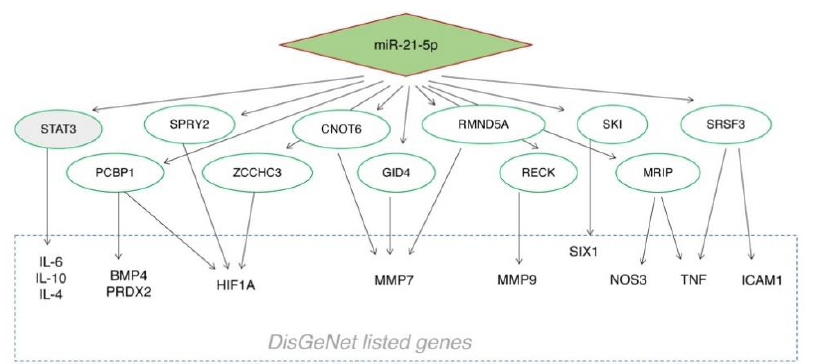
Figure 2. Quantitative analysis of miRNAs expression. qRT-PCR miRNAs expression levels in BOS samples, mir-21 ( a ), mir-146 ( b ), mir34( c ), mir15 ( d ), mir145 ( e ), let7 ( f ), represented as fold changes relative to RNU6.